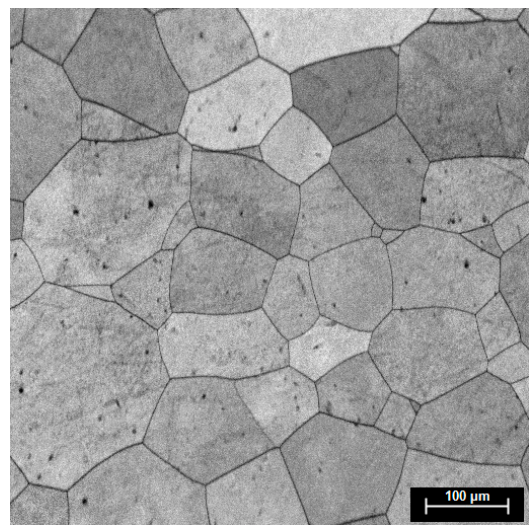
Figure 4. Microstructure of the AR TNTZ alloy.